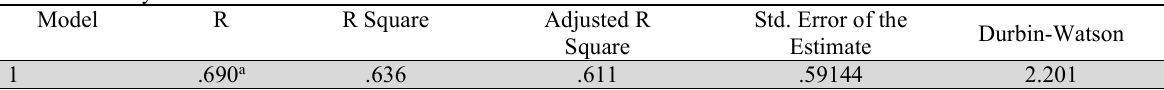
Regression Model Analysis Result